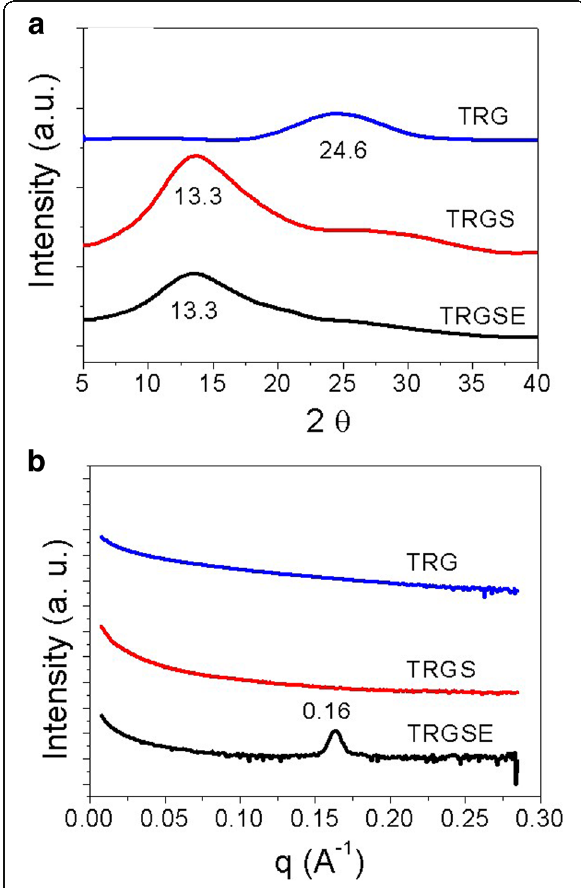
Fig. 5 a The X-ray diffraction scattering and b the small-angle X-ray scattering of the TRG, TRGS, and TRGSE composites Fig. 6 The impedance spectra of the TRG, TRGS, and TRGSE EDLC